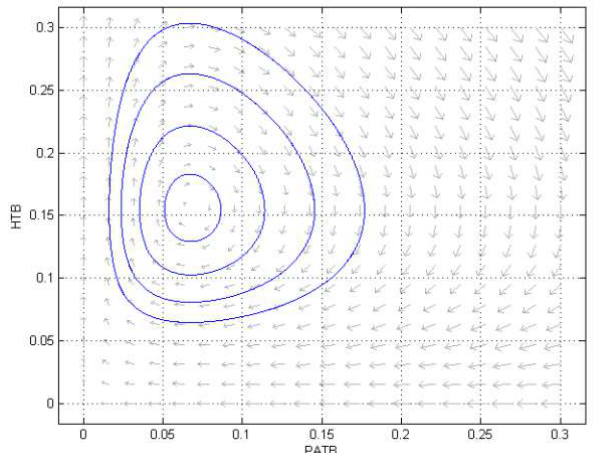
Figure 8. phase transition of co-infection and pre-stage of co-infection. Figure 8. Phase transition of co-infection and pre-stage of